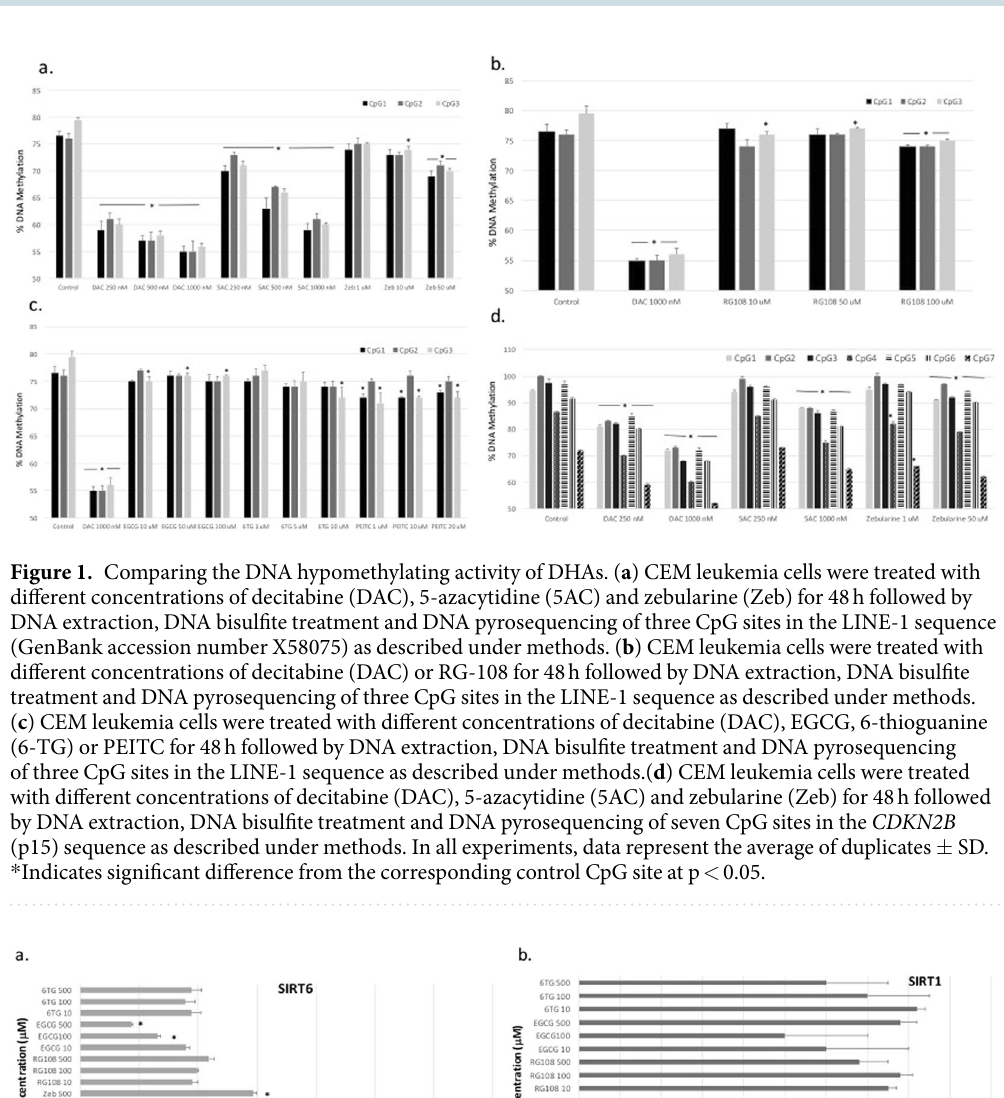
and H3K56 (physiological substrates of SIRT6) was monitored after DAC treatment. A weak decrease in both acetylated H3K9 and H3K56 expression was observed (Fig. 3d) after 24 and 48 h, respectively; consistent with the observed increase in SIRT6 activity and in contrast to stronger decreases observed at specific loci as discussed later. However, acetylated H3K9 showed an increase in expression after 48 h. DAC induces genome-wide changes of H3K9 acetylation. Both H3K9 and H3K56 are known physio- logical substrates of SIRT6 21 . SIRT6 activation by the nucleoside analogs DHAs is expected to decrease the acetyl- ation of both H3K9 and H3K56 genome-wide. To test that hypothesis, purified bone marrow mononuclear cells from six naïve AML patients were incubated with DAC in vitro followed by ChIP-Seq analysis for each patient sample using a validated monoclonal antibody for acetylated H3K9 as described under methods. Data pooling from the six patients showed significant acetylation changes at 187 gene loci after DAC treatment. DAC modu- lated H3K9 acetylation across the 22 autosomes and at different chromosomal regions including coding exons, introns, distal intergenic regions and promoters. Unexpectedly, both increases and decreases in H3K9 acetylation